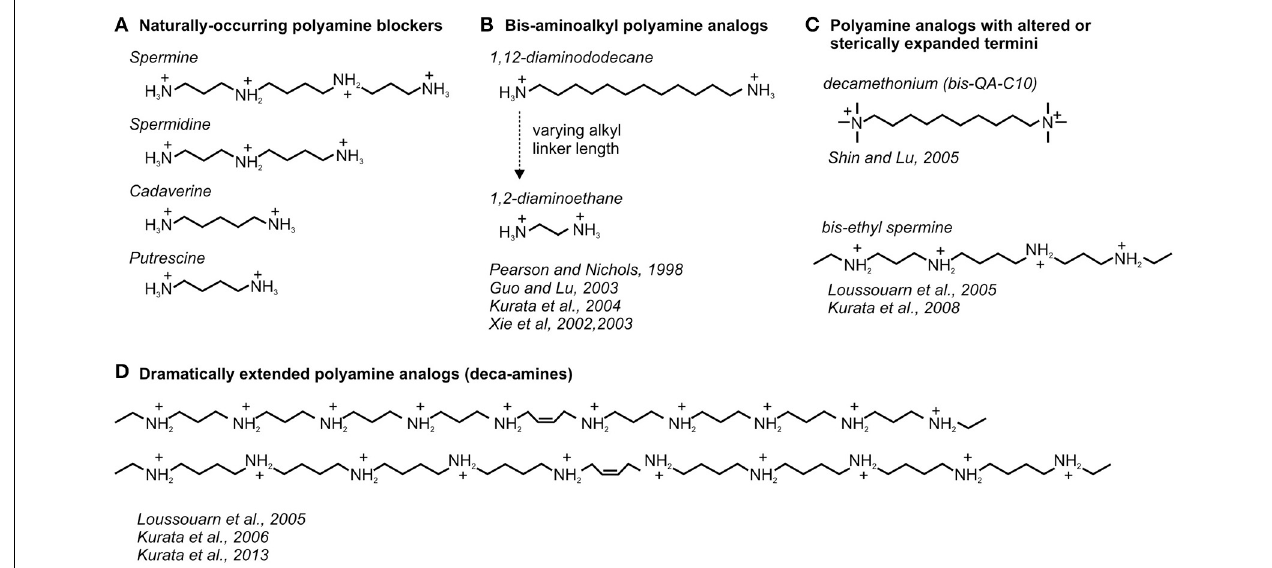
FIGURE 1 | Diversity of natural and synthetic polyamines used to study blockade of Kir channels. Chemical structures of (A) naturally-occurring and (B–D) useful synthetic analogs of polyamine blockers of Kir channels are depicted with exemplar accompanying references.